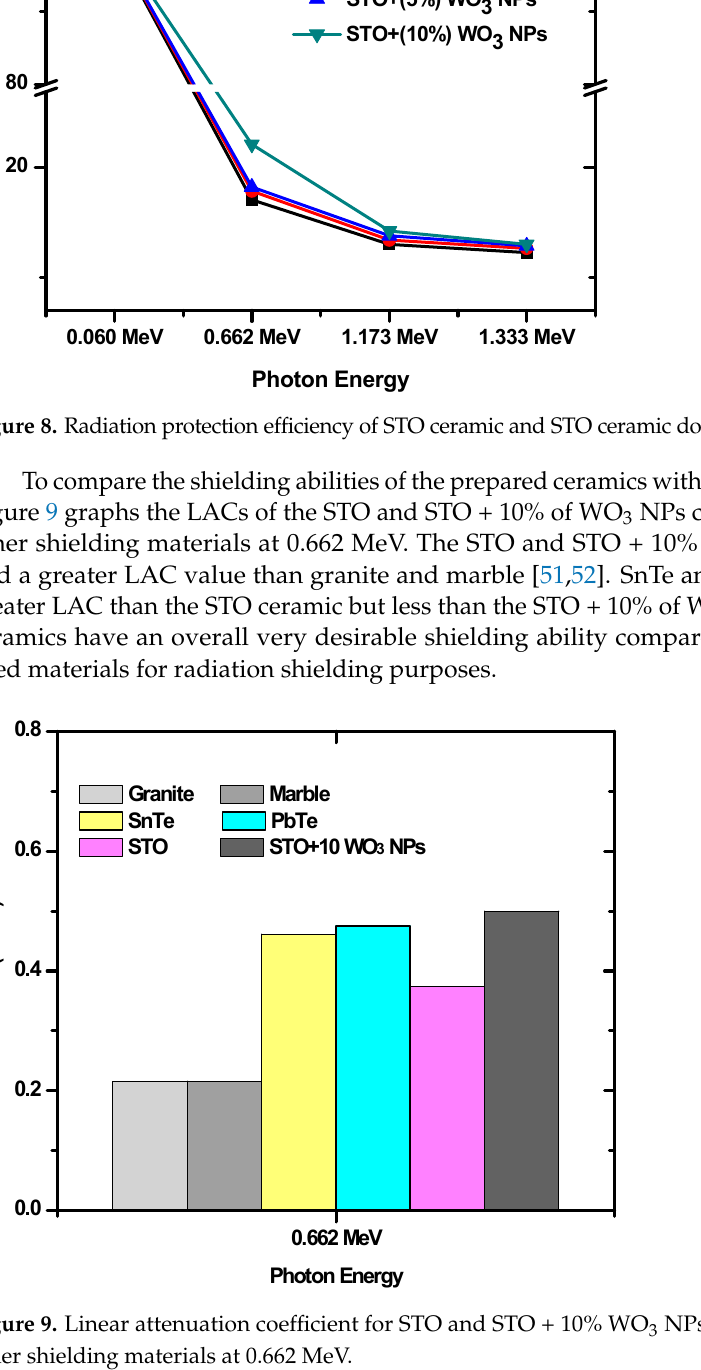
Figure 9. Linear attenuation coefficient for STO and STO + 10% WO 3 NPs ceramics alongside four other shielding materials at 0.662